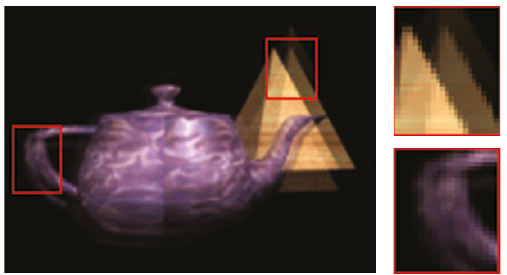
Figure 10: Artifacts in a single-depth rendered image. Right-top: the ghost or double image, right-down: blur situation.